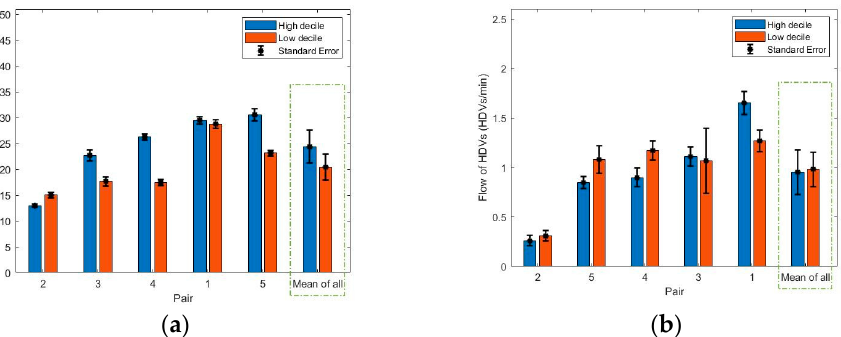
Figure 6. Bar plot of ( a ) traffic flow of all vehicles (vehicles/min), ( b ) traffic flow of HDVs (HDVs/min) along the main road segment (high traffic component) of each route collected over the 7–8 days of observation.